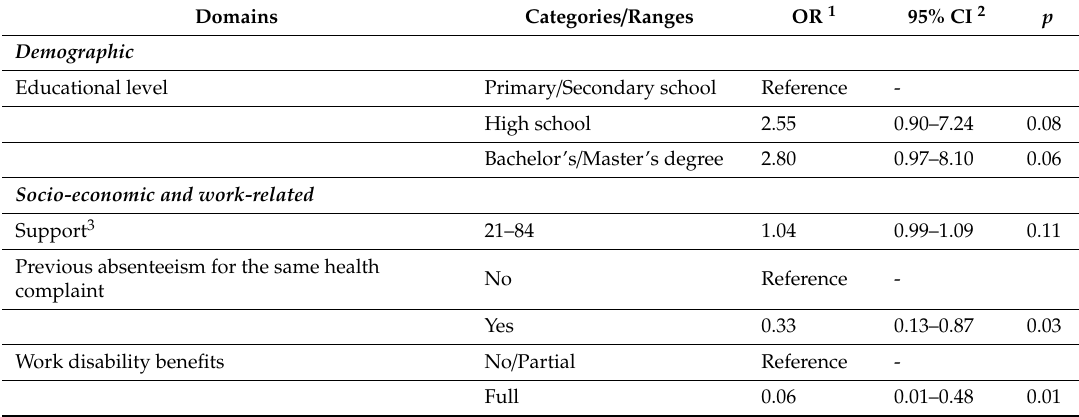
Table 3. Multivariable logistic regression analyses of 11 remaining potential predictors for staying at work for participants with subjective health complaints (SHC) per domain